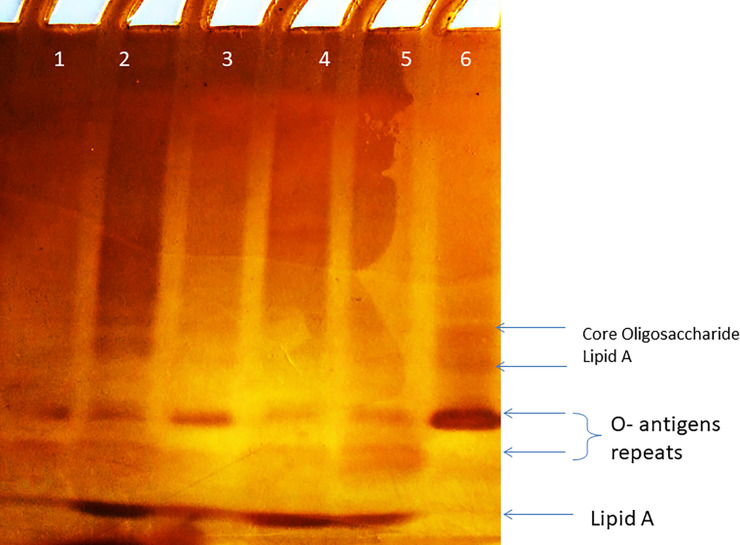
LPS SDS-polyacrylamide gel profile stained by silver nitrate.Lanes 1, 2, 3&4 (P5, P8, P9 and P16 isolates with anticandidal activity). Lane 5 and Lane 6 (P111 and P118 isolates with no anticandidal activity).